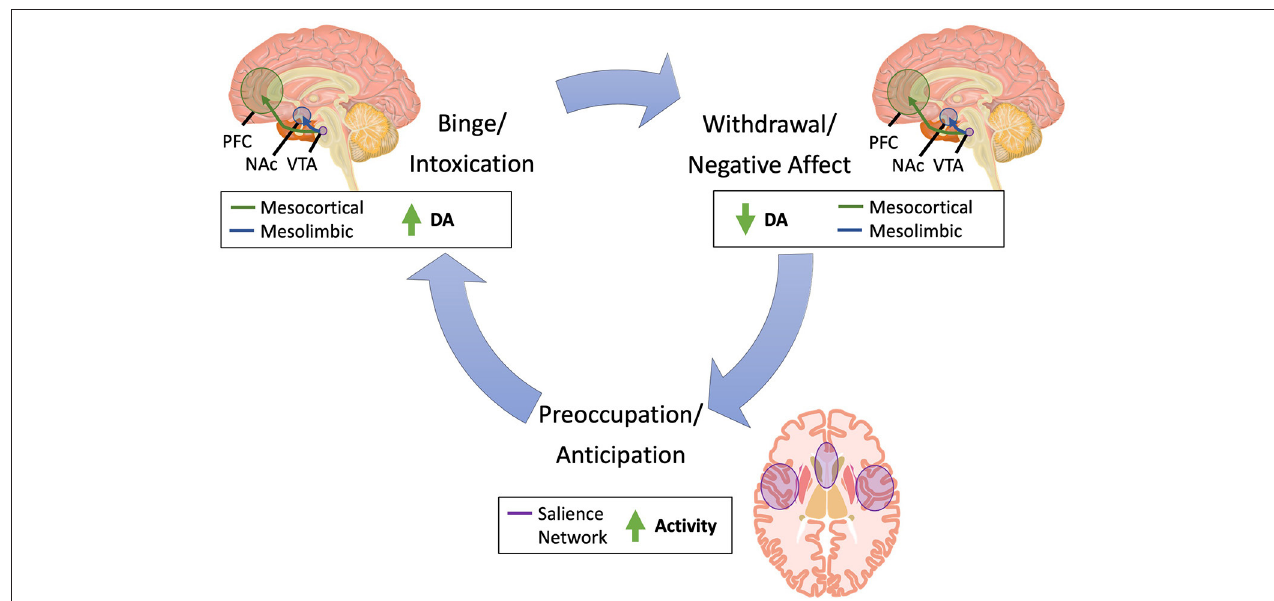
FIGURE 1 | Brain pathways implicated in substance use. Substance use is characterized by three primary phases: (1) binge/intoxication, (2) withdrawal/negative affect, and (3) preoccupation/anticipation ( 14). In the binge/intoxication phase, substance use leads to acute increases in dopamine in the mesolimbic and mesocortical circuitry, which drives incentive salience and drug-seeking. In the withdrawal/negative affect, dopamine acutely decreases in these same circuits, leading to negative emotional states and dysphoric and stress responses. Finally, in the preoccupation/anticipation phase, increased activity in the salience network, which includes the insula and dorsal anterior cingulate cortex, leads to craving and deficits in executive function. DA, dopamine; NAc, nucleus accumbens; PFC, prefrontal cortex; SN, substantia nigra; VTA, ventral tegmental